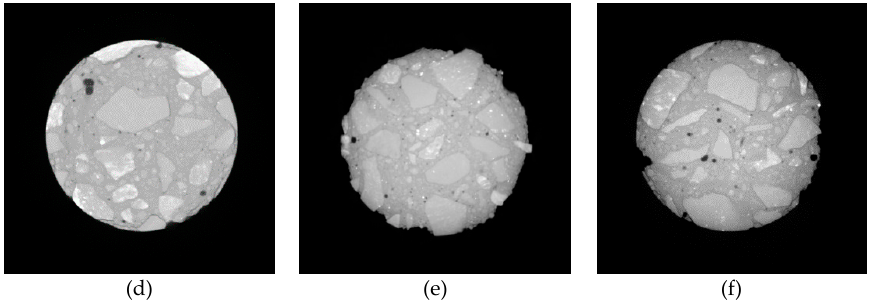
Figure 14. CT scanning images of different nano-particle added concrete subjected to 25 FTCs. ( a ) 15 nm-NS (0.2%); ( b ) 15 nm-NS (0.6 %); ( c ) 30 nm-NS (0.2%); ( d ) 30 nm-NS (0.4%); ( e ) 30 nm-NT (0.2%); ( f ) 30 nm-NT (0.6%).